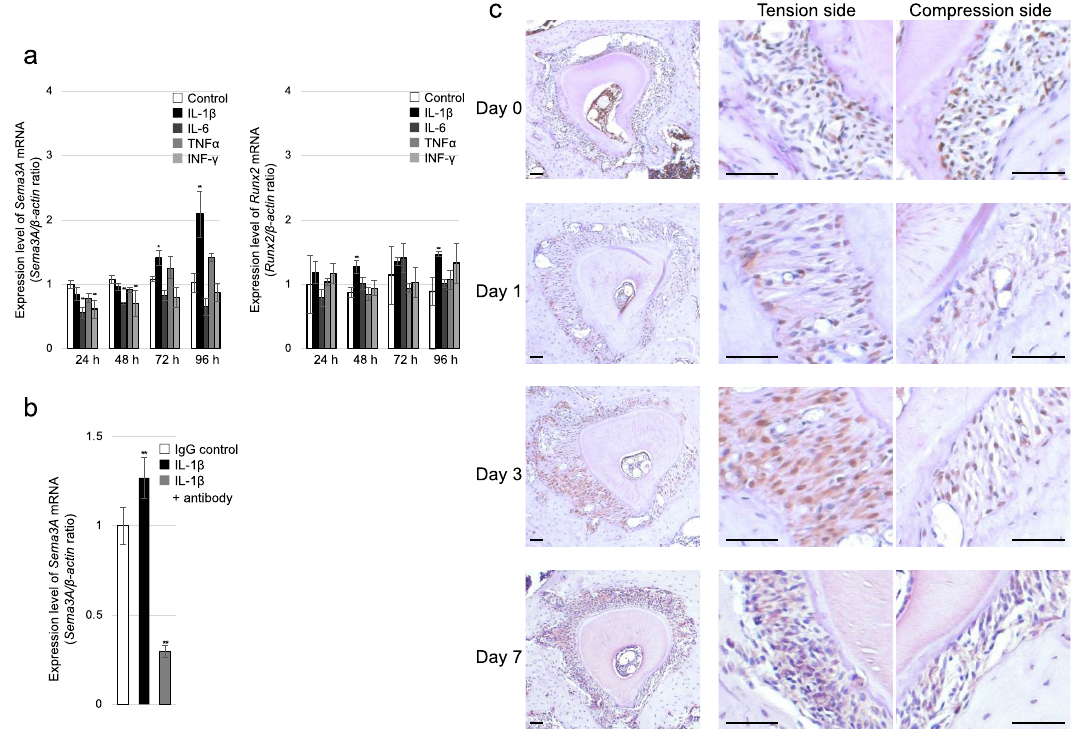
Figure 5. ( a ) Sema3A and Runx2 mRNA quantification by RT-qPCR in osteoblasts after 24, 48, 72, and 96 h in the absence or presence of inflammatory cytokines. Sema3A expression was significantly increased at 72 h and 96 h with IL-1β and significantly reduced after 24 h and 48 h with IL-6 and IFN ‐ γ. The bars represent Sema3A and Runx2 mRNA levels relative to β-actin mRNA levels. (n = 3) ( b ) Sema3A mRNA quantification by RT-qPCR in osteoblasts treated with IgG control, IL-1β and IL-1β receptor antibody. (n = 5) Data are presented as mean ± SD. * p < 0.05 and ** p < 0.01. ( c ) Immunohistochemistry for IL-1β. Horizontal sections at days 0, 1, 3, and 7 after OTM. There were more IL-1β-positive cells in the tension side compared to the compression side on days 1, 3, and 7. Scale bars = 50